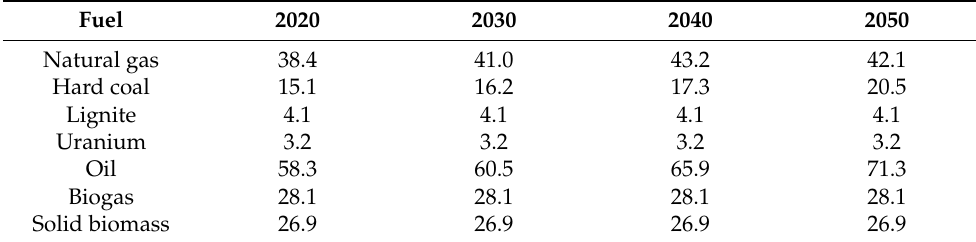
Table 1. Assumed fuel costs in € /MWh in the scenario.